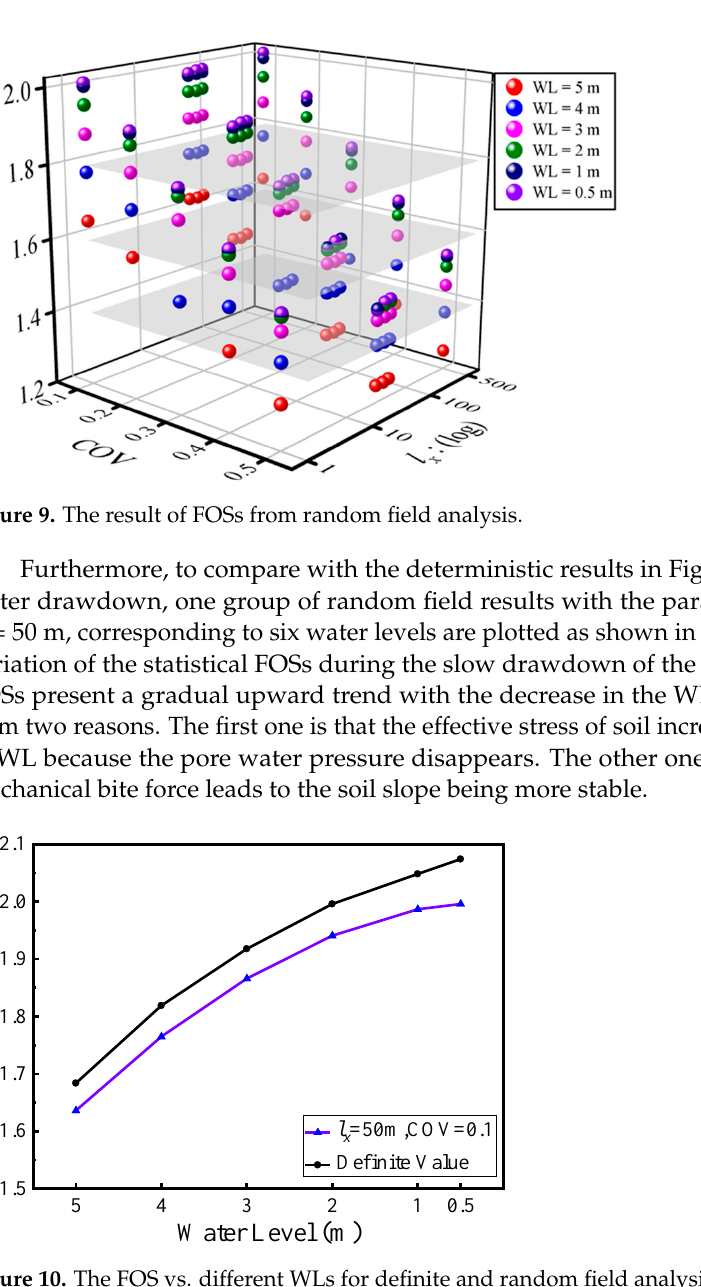
Figure 10. The FOS vs. different WLs for definite and random field analysis.